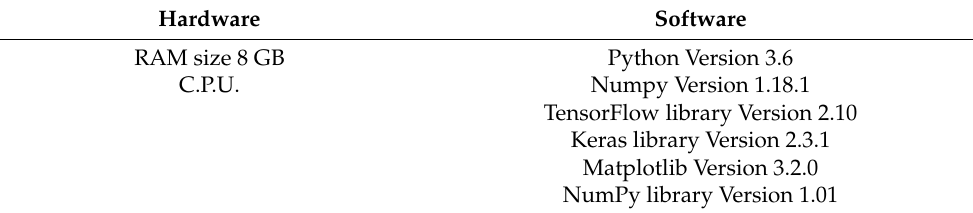
Table 4. Environment requirements of the proposed